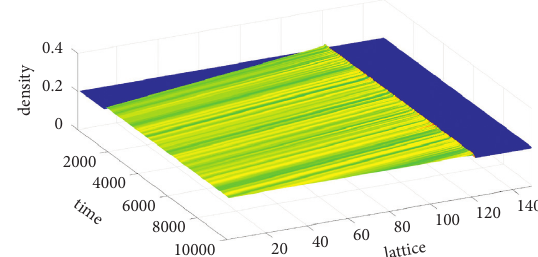
Figure 6: Spatiotemporal evolution pattern.